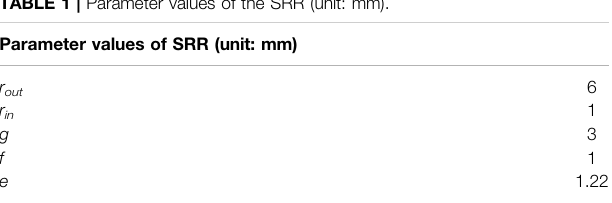
Frontiers in Physics |